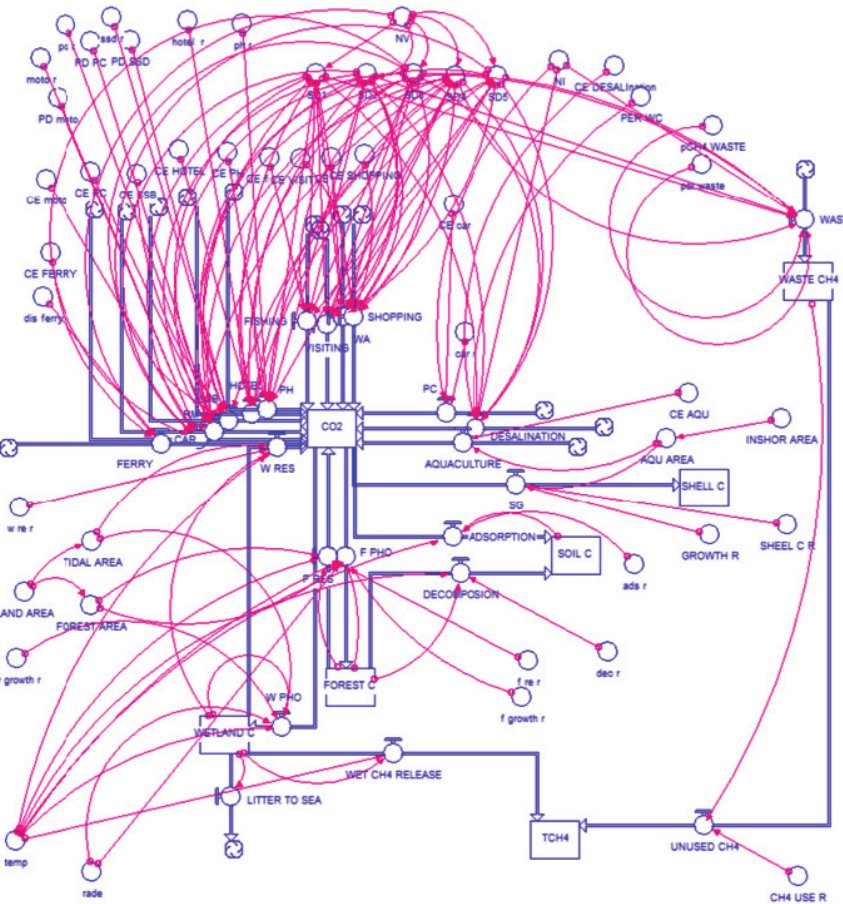
Figure 3: Conceptual STELLA diagram of for the social-ecological process carbon cycle model on Gouqi